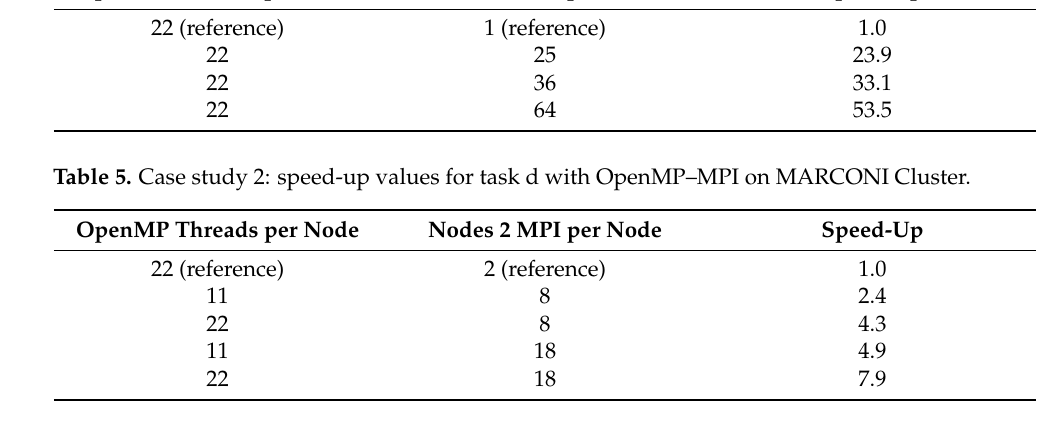
Table 4. Case study 2: speed-up values for task b, with OpenMP–MPI on MARCONI Cluster. OpenMP Threads per Node Nodes 1 MPI per Node